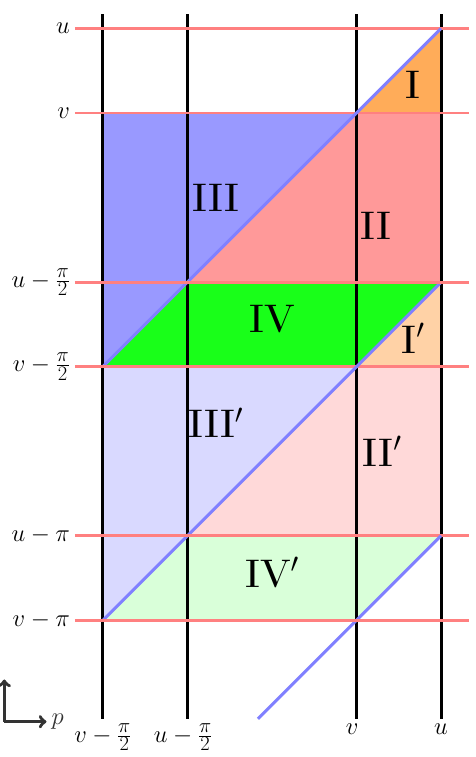
Figure 2 . The integration range is depicted in this